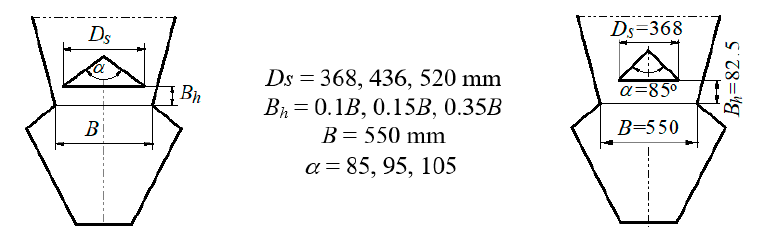
Figure 5. Cone geometry in lower part of the cyclone. Main dimensions: Ds –cone diameter, B h –distance from the cone base to the cyclone bottom outlet, B –cyclone outlet diameter, α –cone apex angle.